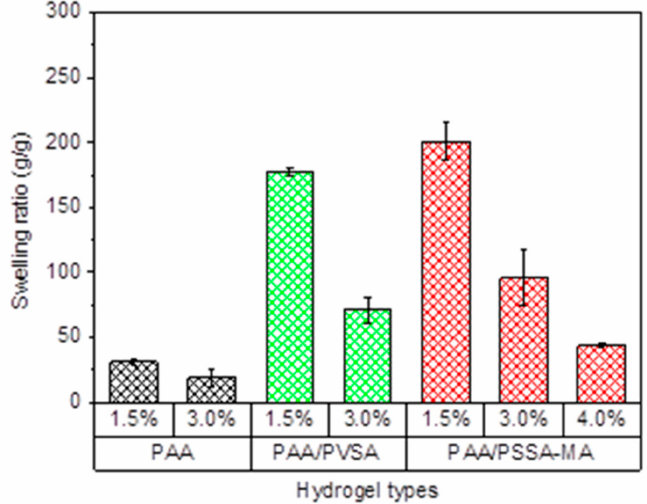
Figure 2. Swelling ratio of the different hydrogel groups: poly(acrylic acid) (PAA), copolymer (acrylic acid- co -vinyl sulfonate sodium) (PAA/PVSA), semi-IPN of poly(4-styrene sulfonic acid- co -maleic acid) sodium salt in PAA network (PAA/PSSA-MA). The percentages indicate the crosslinking